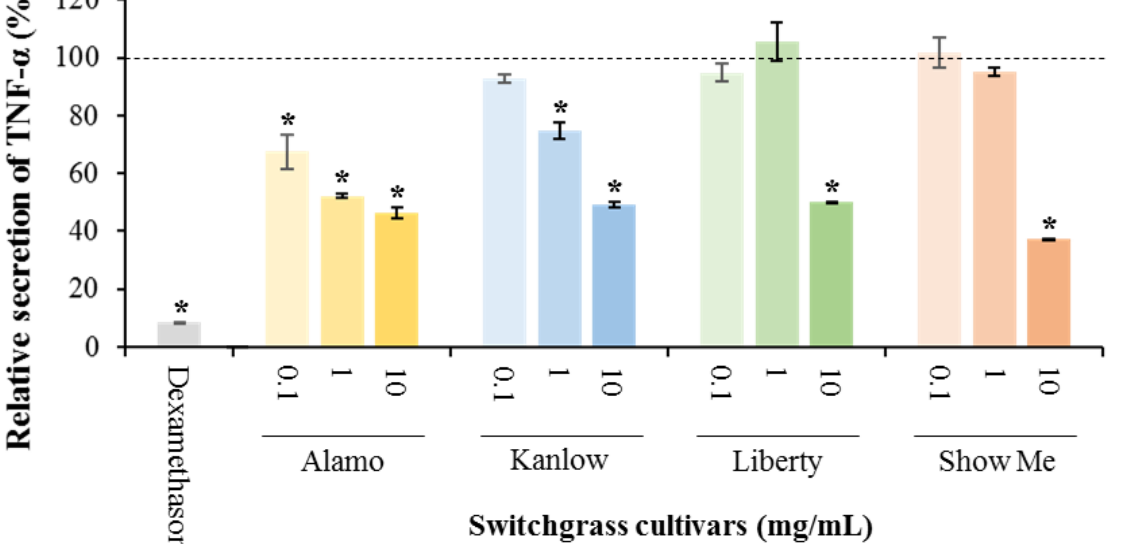
Figure 1. Effect of the switchgrass extracts on the expression of TNF- α in the U-937 model system. (*) Significant decrease ( p < 0.01) compared to the control cells without the extract. Mean ± SEM.